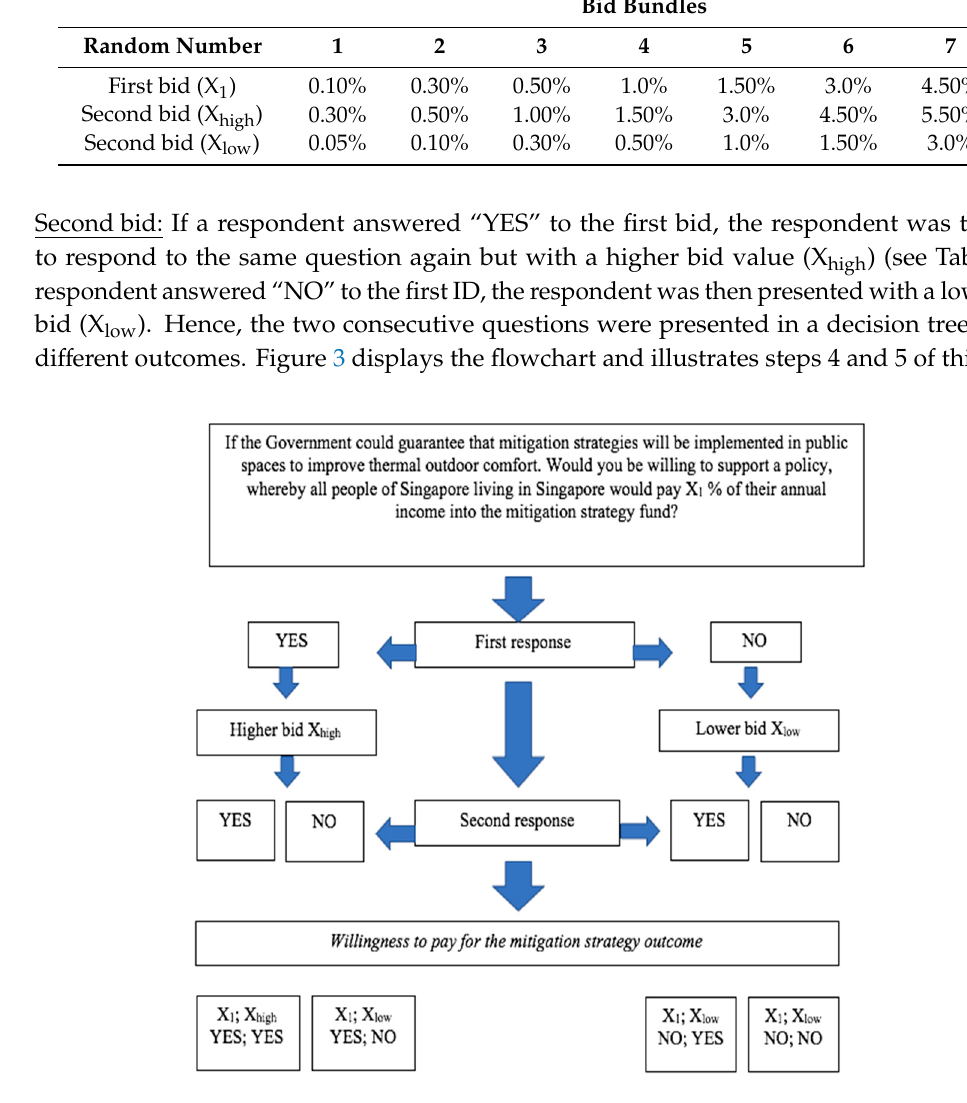
Figure 3. Decision tree of our double-bounded dichotomous choice survey. The bid values X 1 , X High , and X Low were randomly varied across the questionnaires following Table 2.